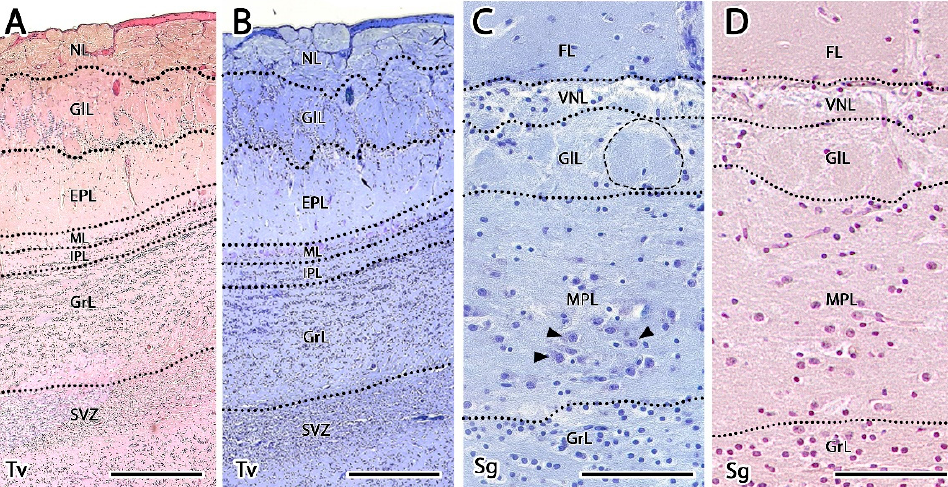
Figure 5. Histological comparative study of the lamination of both the main and accessory olfactory bulbs. Lamination of the main olfactory bulb showed with HE ( A ) and Nissl staining ( B ): olfactory nerve layer (NL), glomerular layer (GlL), external plexiform layer (EPL), mitral layer (ML), internal plexiform layer (IPL), granular layer (GrL), subventricular zone (SVZ). The lamination of the accessory olfactory bulb is shown with HE ( C ) and Nissl staining ( D ): vomeronasal nerve layer (VNL), glomerular layer (GlL), mitral-plexiform layer (MPL) and granular layer (GrL). The small degree of differentiation of the accessory olfactory bulb glomeruli is mainly due to the scarcity of periglomerular cells. Only in a few cases (dotted line) is the usual spherical shape visible. The main cells of the AOB are diffusely distributed along the mitral-plexiform layer, especially in its deepest zone. They are oval or polyhedral in shape (black arrowhead). Granular cells are smaller and distributed in irregular clusters. Front lobe of the telencephalon (FL). Tv: transversal plane, Sg: sagittal plane. Scale bars: ( A – D ): 100 μ m.